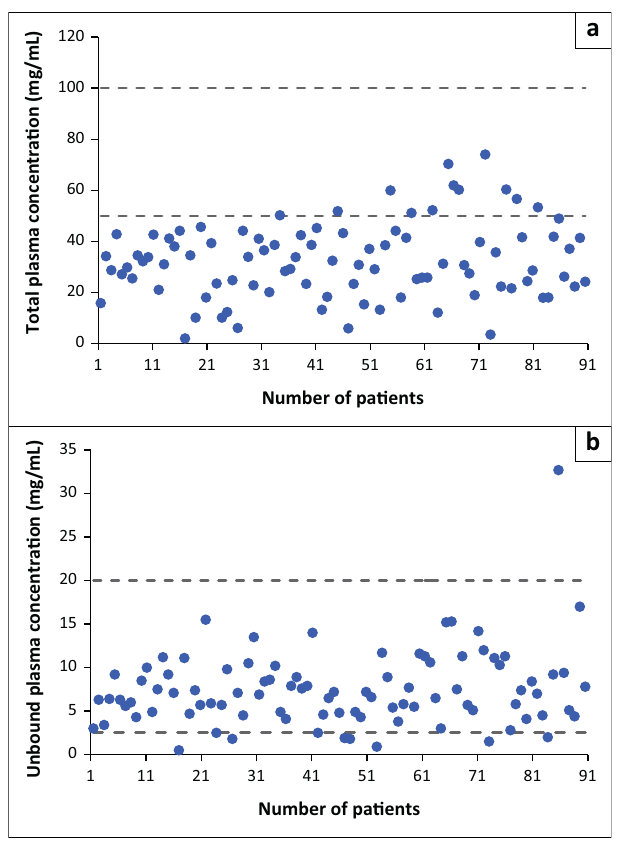
FIGURE 2: Plasma concentrations of (a) total and (b) unbound valproic acid plasma concentration in 93 critically ill patients in the Intensive Care Unit at Windhoek Central Hospital (Windhoek, Namibia) from January 2013 to July 2019. The therapeutic range is indicated by dashed lines. The suggested therapeutic range for unbound valproic acid concentrations is quite wide because the lower and upper limits of therapeutic ranges reported in the literature differ